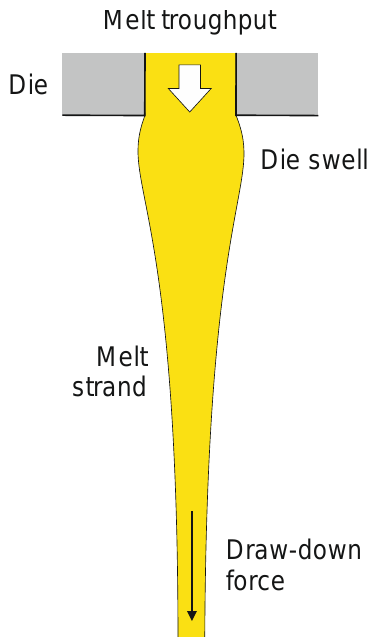
Figure 4. Die swell and fiber drawing. By way of illustration, the polymer melt is represented in yellow.